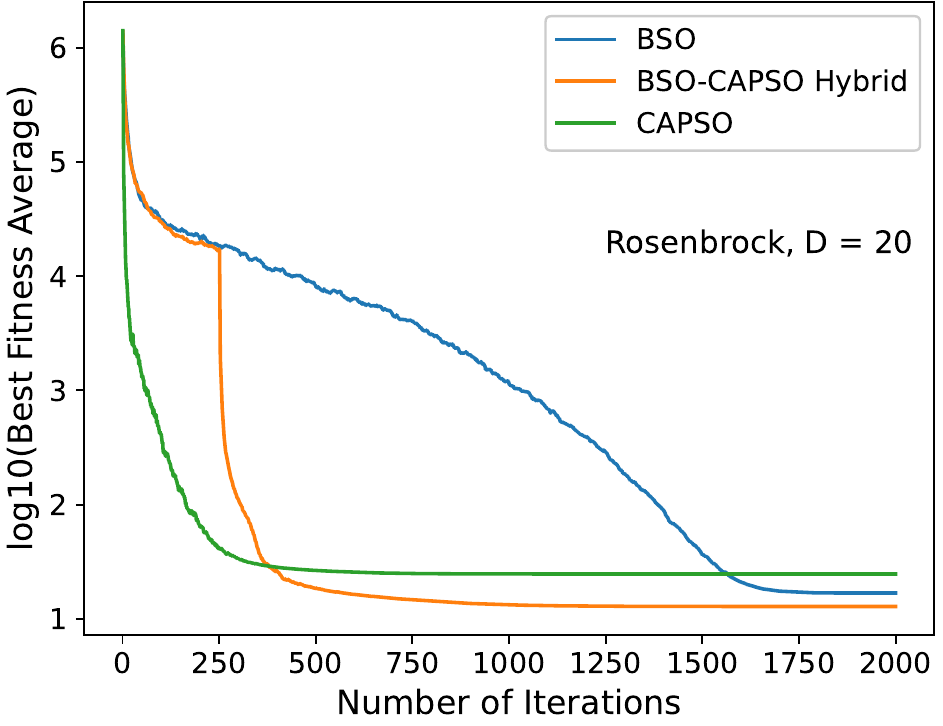
Figure 6. Convergence diagram of the stand-alone BSO, BSO–CAPSO hybrid and stand-alone CAPSO algorithms for the Rosenbrock ( f 2 ) function with D = 20. Convergence acceleration occurred after t switch = 250.